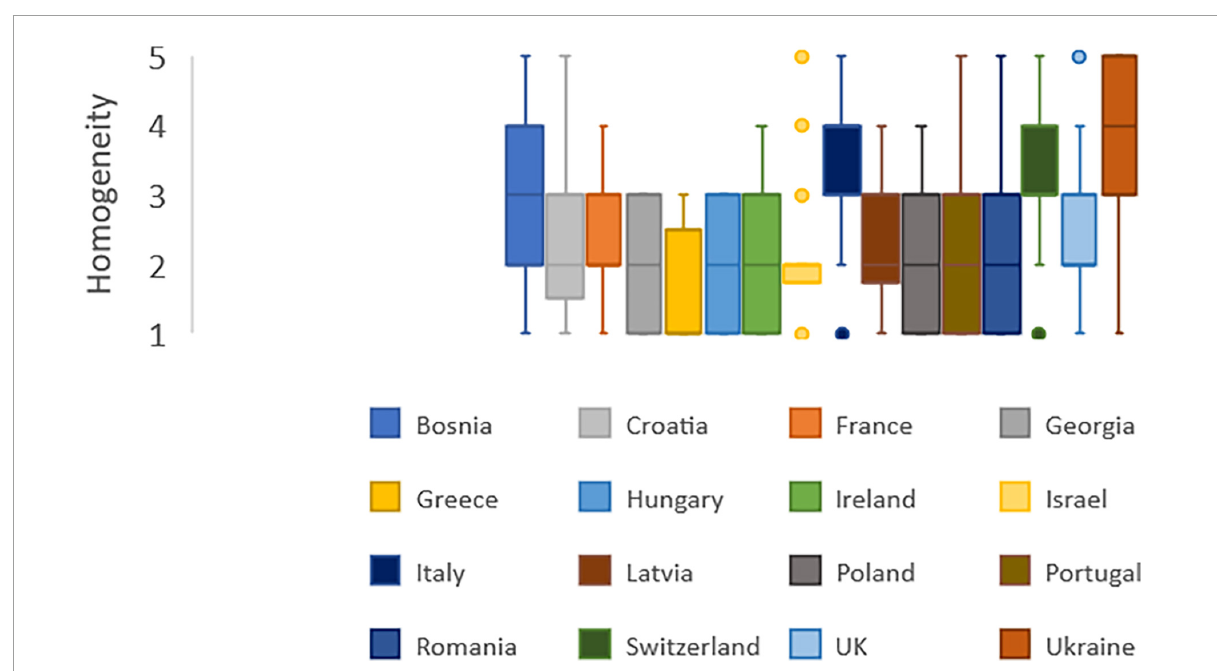
FIGURE5 Intermediate care services: Homogeneity of diffusion. 1: not at all homogeneous. 5: completely homogeneous.